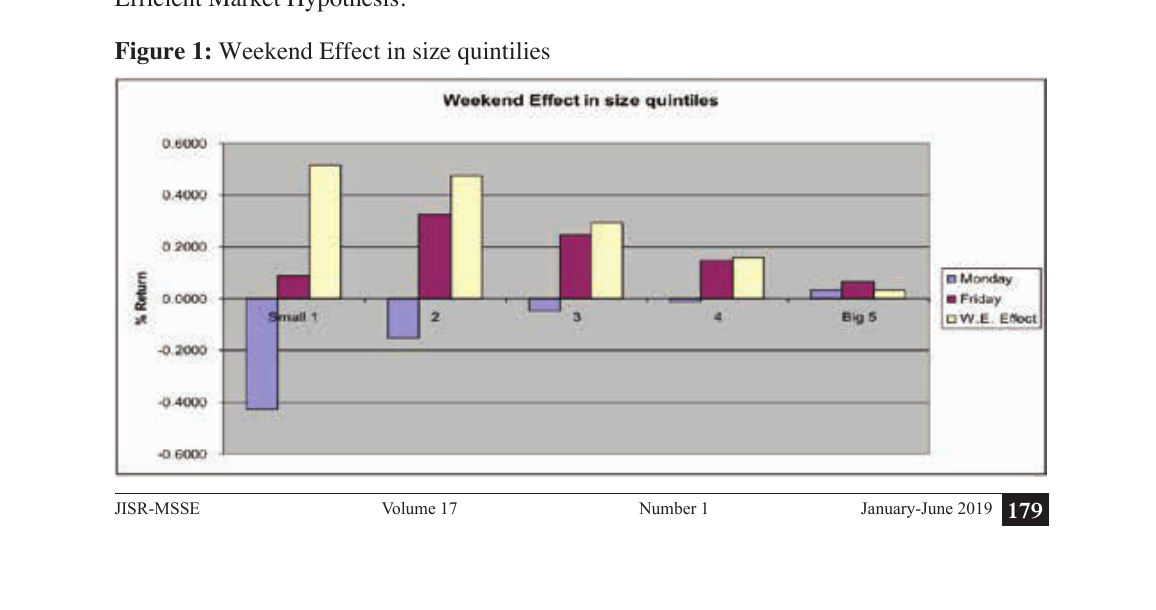
Figure 1: Weekend Effect in size